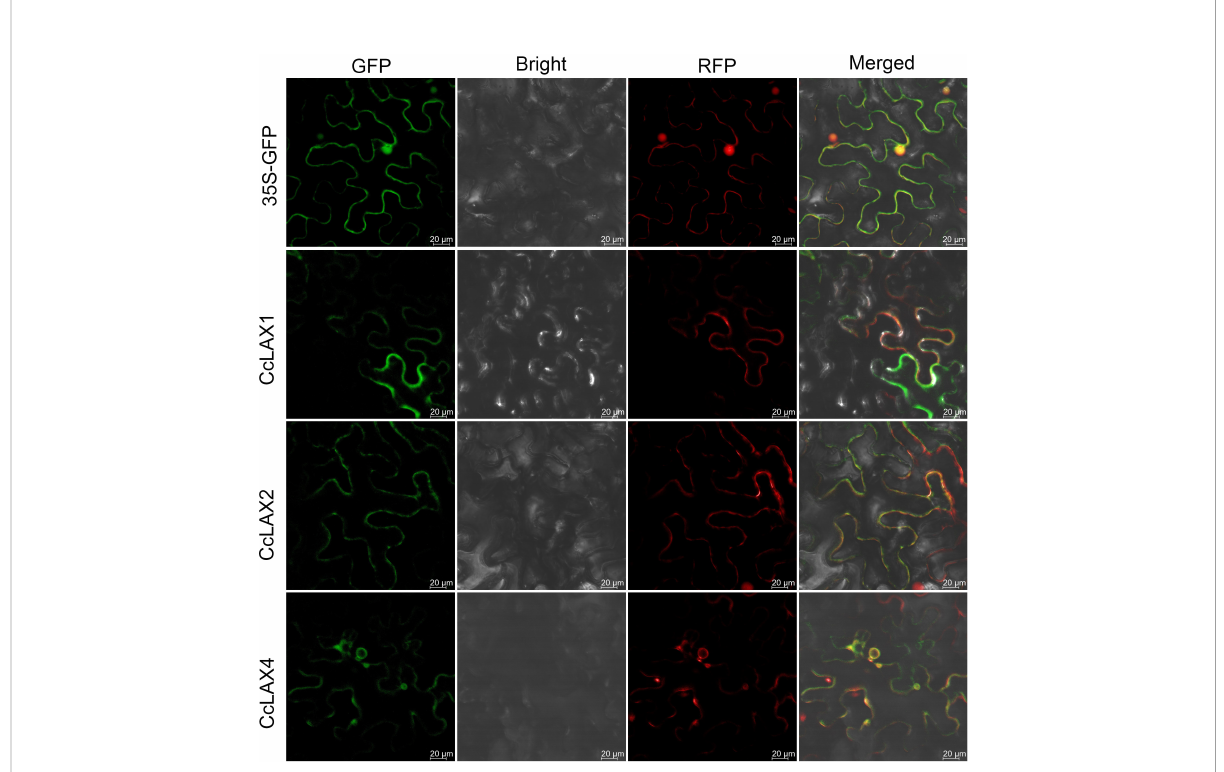
FIGURE 5 Subcellular localization of CcLAX1, CcLAX2 and CcLAX4 proteins. Left to right: green fl uorescence (GFP), bright fi eld (Bright), red fl uorescence (RFP), and merged microscope images (Merged). Bar = 20 m